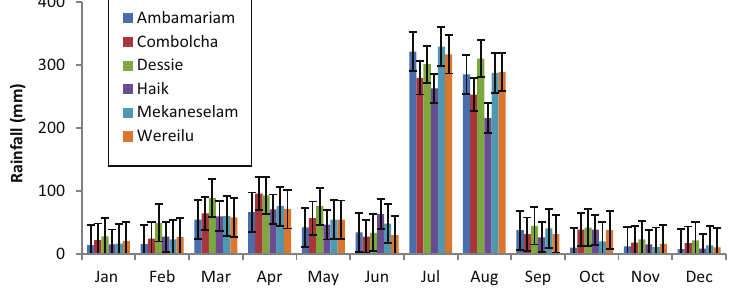
Figure 2. Bimodal rainfall distribution of the study